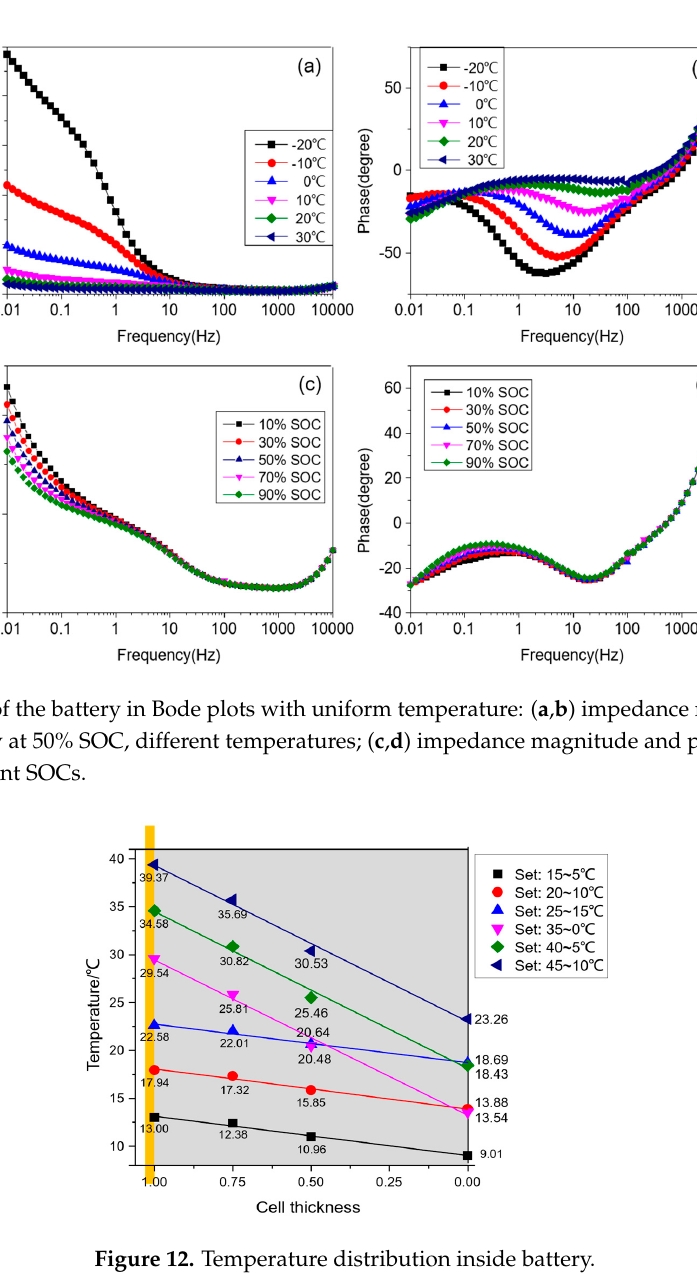
Figure 13. EIS of battery in Bode plots with different artificial temperature gradients: ( a ) impedance magnitude; ( b ) impedance phase. There is another point worth noting in Figure 12: the magenta line and the olive line intersect at the half of the battery. According to the assumption that the temperature is linearly distributed, the temperature at the battery’s center can be considered as the average battery temperature. A situation whereby several experiments under different temperature gradients but the same battery average temperature demonstrate similar impedance characterization should be verified and discussed. We select some experiments with approximate average temperature, including the lower average temperature (1 °C ) and the higher average temperature (21 °C ) . Besides these, we also supplement the experiments with those of 1 °C and 21 °C uniform temperature. Figure 14 shows the